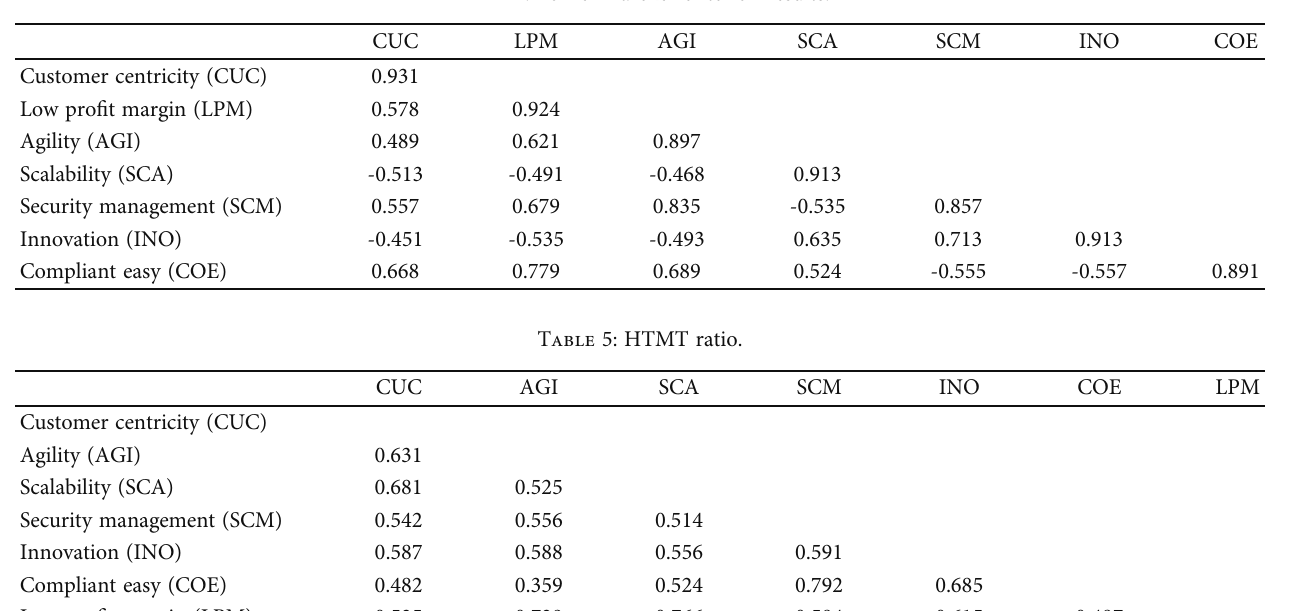
Table 4: Fornell-Larcker criterion